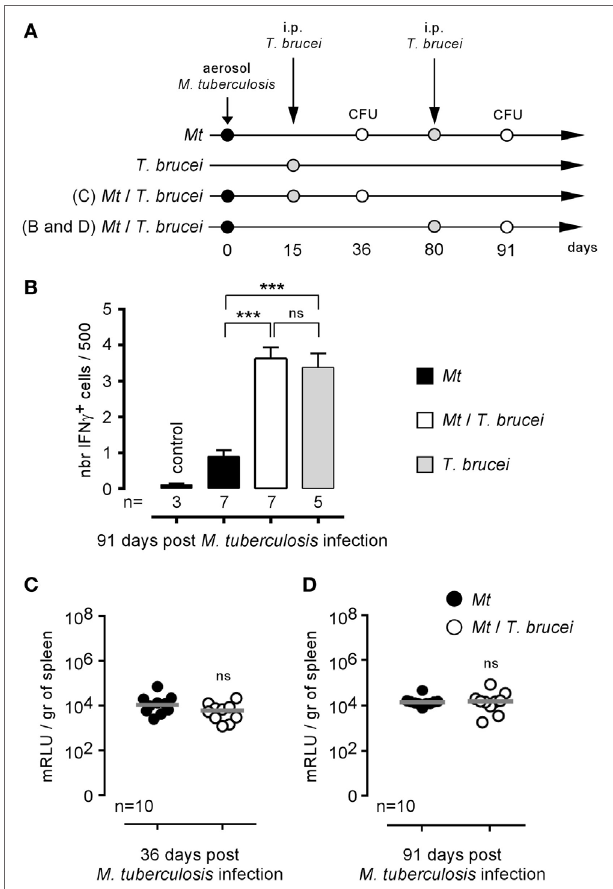
FigUre 6 | Impact of Trypanosoma brucei co-infection on the course of Mycobacterium tuberculosis infection in mice. Wild-type C57BL/6 mice were infected by aerosol with 5 × 10 3 CFU of M. tuberculosis and, at 15 or 80 days postinfection, received an i.p. injection of 5,000 T. brucei in 200 µl of PBS ( M. tuberculosis / T. brucei group) or PBS alone ( M. tuberculosis group). The mice were euthanatized at the selected time post M. tuberculosis infection, and the spleen was harvested, as described in panels (a,B) . The data represent the frequency of IFN γ -producing cells in the spleen as determined by flow cytometry analysis. (c,D) The data represent the number of mRLU/g of spleen. Gray bars represent the median. n denotes the number of mice used for each group (*** p < 0.001). These results are representative of at least two independent